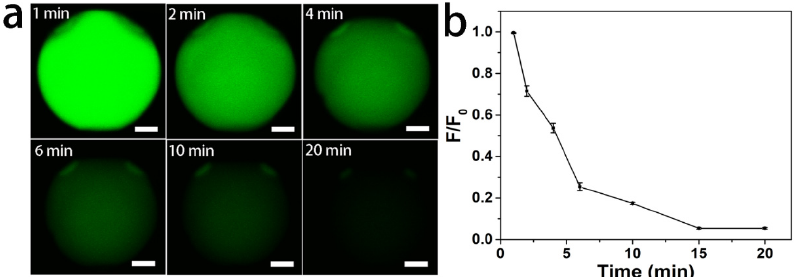
Figure 4. ( a ) Fluorescence microscope images of autofluorescent BSA sphere at different injection times and ( b ) the corresponding F/F 0 curve of the autofluorescent BSA hydrogel microspheres in the presence of MnO 4 − (80 μ M). F and F 0 are the fluorescence intensities of the autofluorescent BSA hydrogel microspheres excited at 488 nm in the presence and absence of MnO 4 − , respectively. All scale bars are 10 μ m. The error bars represent the standard deviation of three measurements.